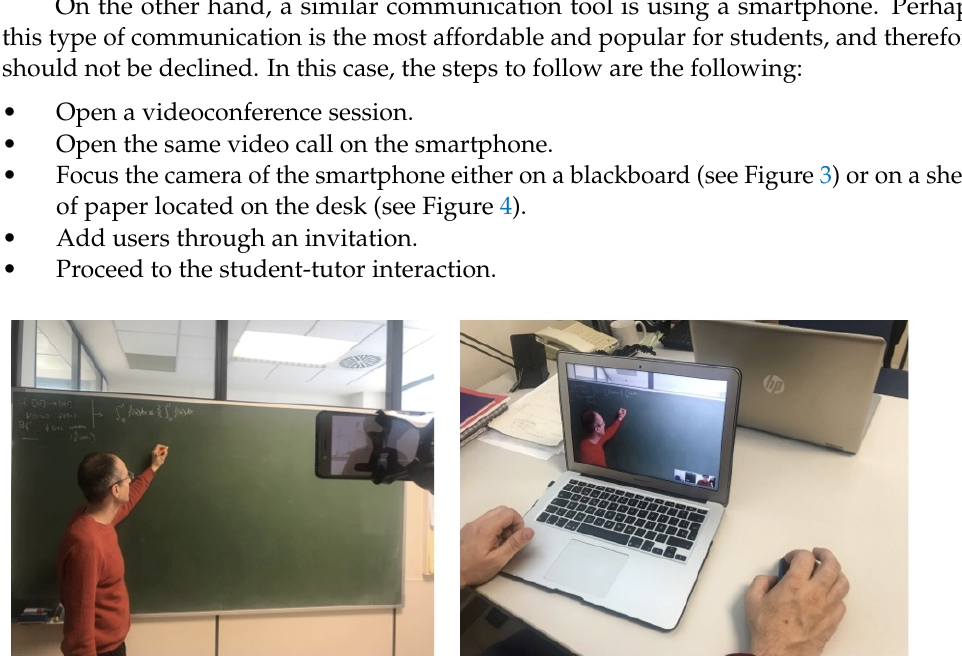
Figure 3. Office hours through videoconferencing using traditional whiteboard. On the left, the teacher answers the students’ questions by focusing on the blackboard with the smartphone’s camera, while the student follows the explanations (right side) with his